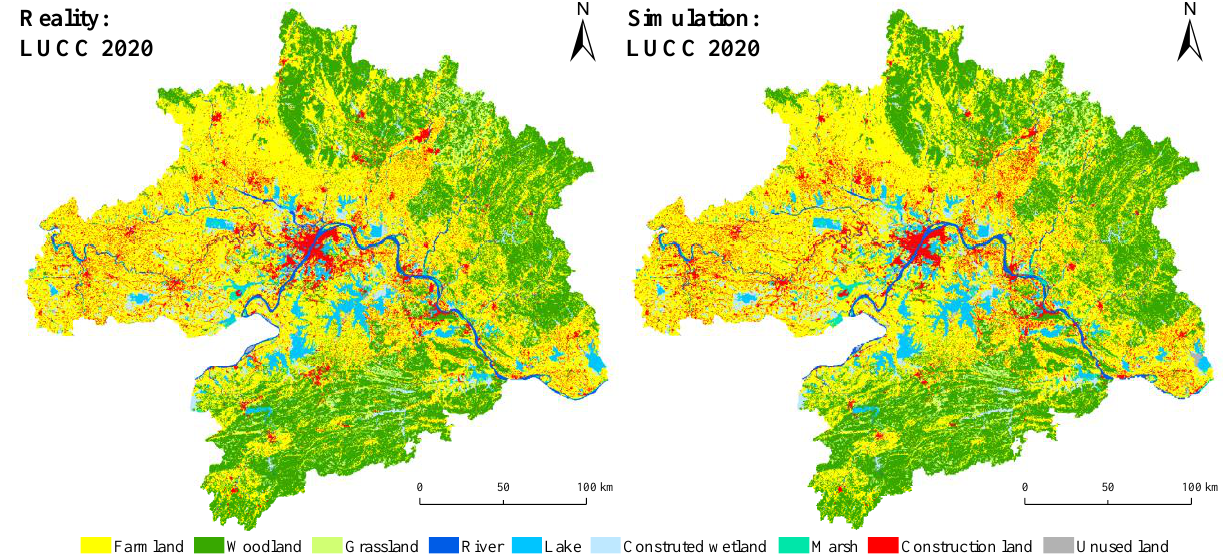
Figure 4. Accuracy of actual and simulated land-use results in 2020 (calculated with Equations